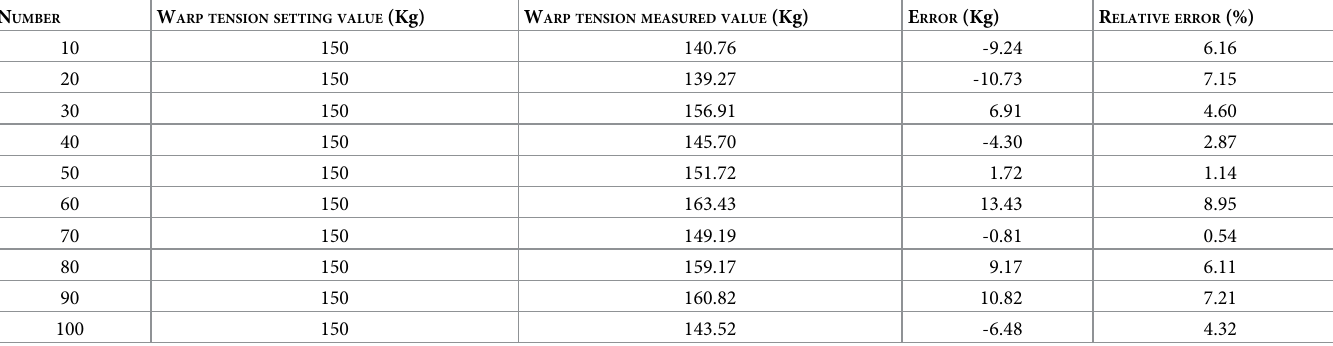
Table 1. PID algorithm warp tension measured values and error comparison